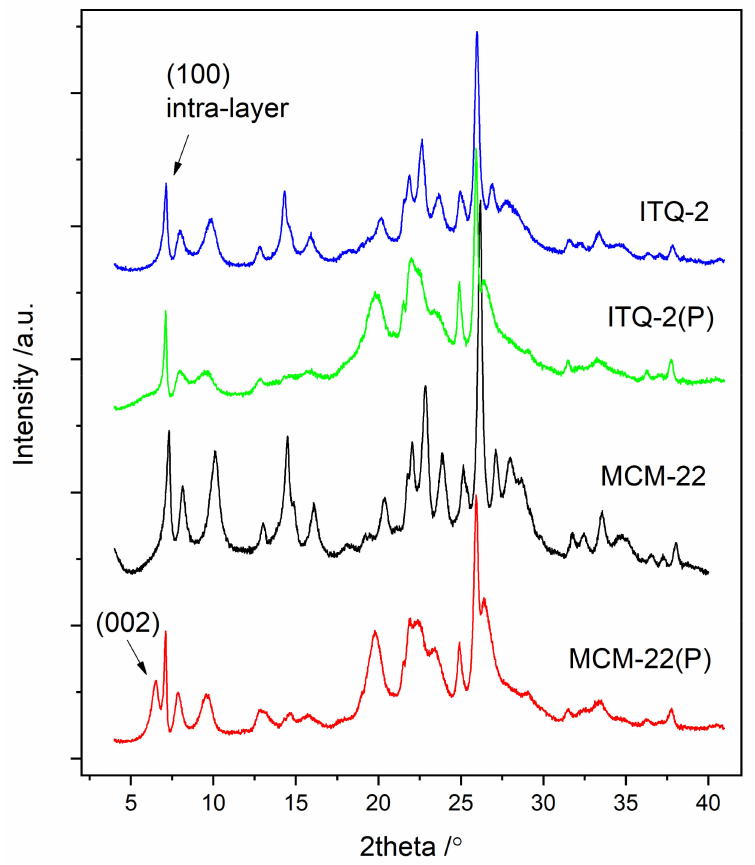
Figure 1. XRD patterns of MCM-22 and ITQ-2 zeolites before and after